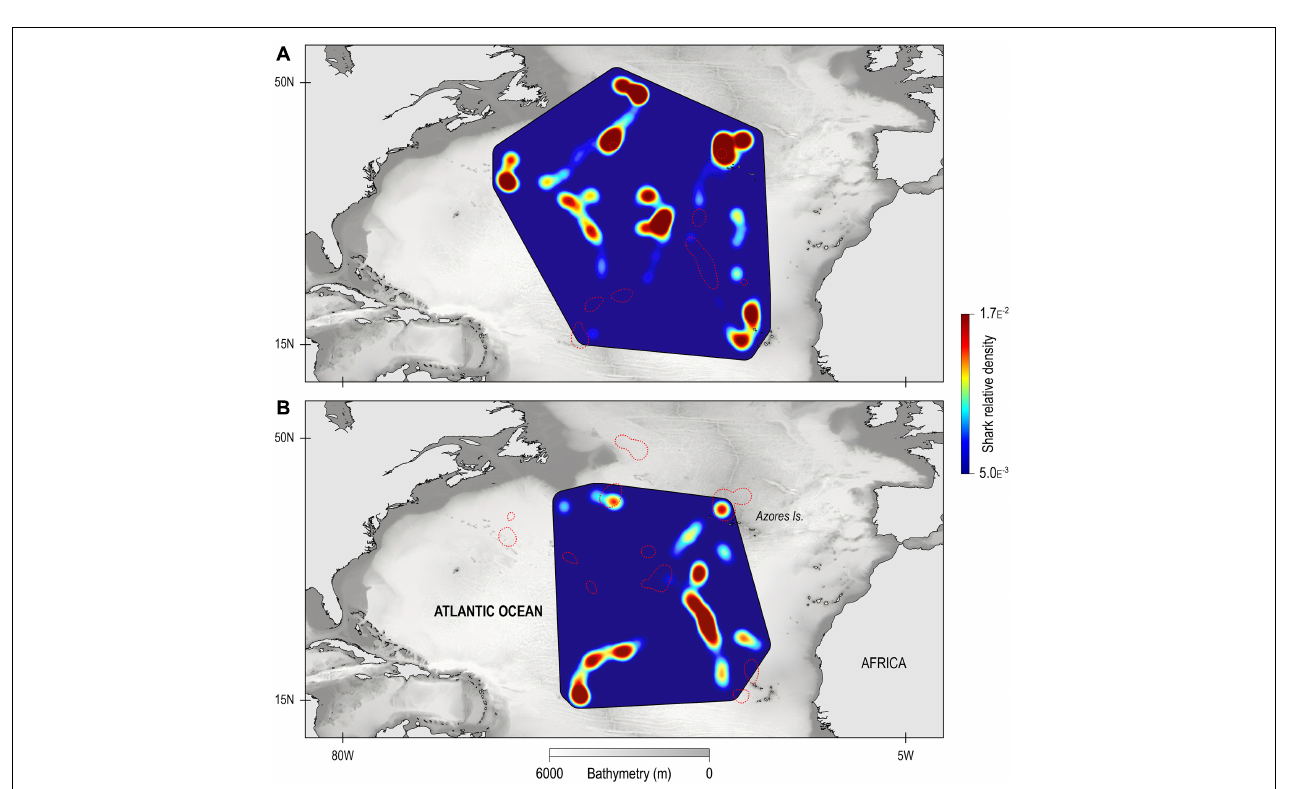
FIGURE 7 | Kernel density estimates of space-use of tracked blue sharks, for (A) nDVM and (B) depth-oriented nDVM. The red dashed line denotes the 90th percentile for depth-oriented nDVM (top) and nDVM (bottom) shown to exemplify the mismatch in hotspot location of the different